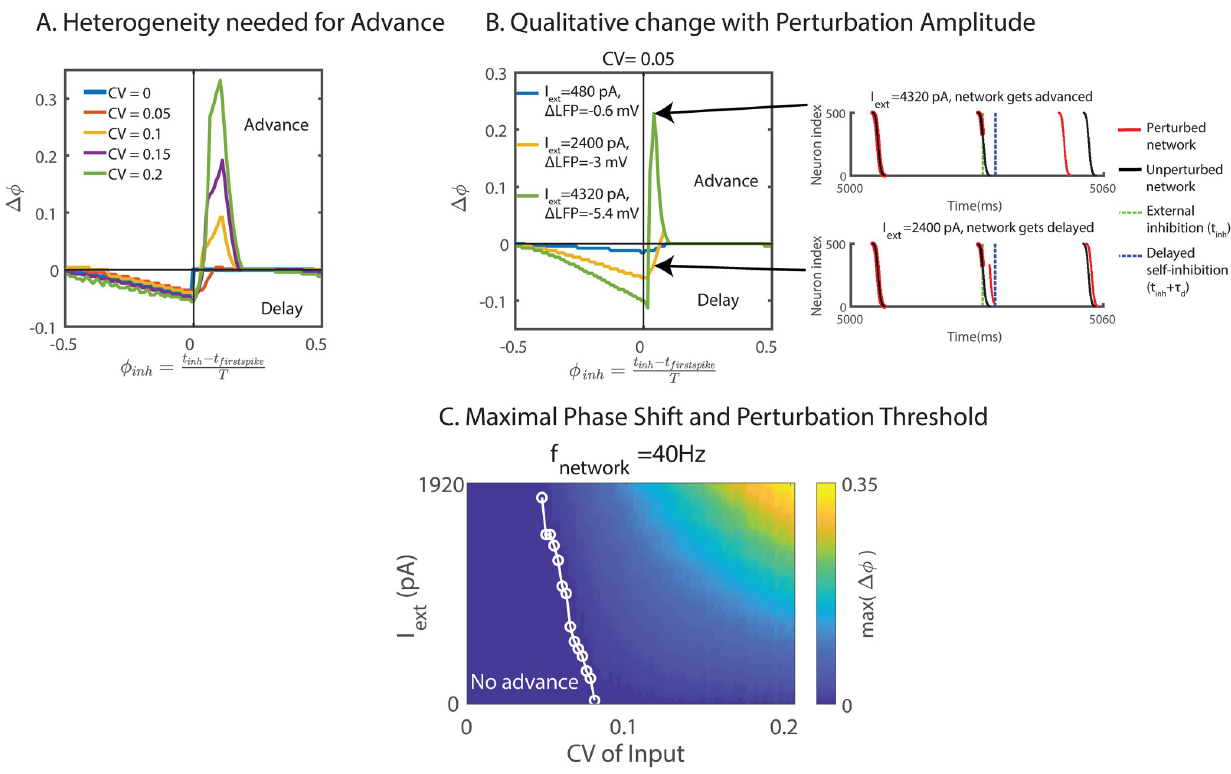
Fig 2. fmPRC of heterogeneous ING network. (A) Phase shift in response to inhibition for different neuronal heterogeneity but fixed natural frequency ( f network = 40Hz). The paradoxical phase advance increased with neuronal heterogeneity. (B) fmPRC changed qualitatively with the amplitude of the perturbation. Left: fmPRC for three different perturbation amplitudes. Right: raster plot of spikes without (black) and with (red) external inhibition. Top: strong perturbation advanced the network. Bottom: weak perturbation applied at the same time as in the top figure. The network was delayed. (C) Maximal phase advance as a function of neuronal heterogeneity and external inhibition strength. The threshold of the inhibition amplitude to obtain an advance decreased with heterogeneity (white line). f was kept constant ( f = 40Hz). In (A)-(C), perturbations were made with a square-wave inhibitory network network current pulse with duration 0.1 ms to each neuron. In (A), the amplitude of the current was 1600 pA, resulting in a 2 mV rapid hyperpolarization.